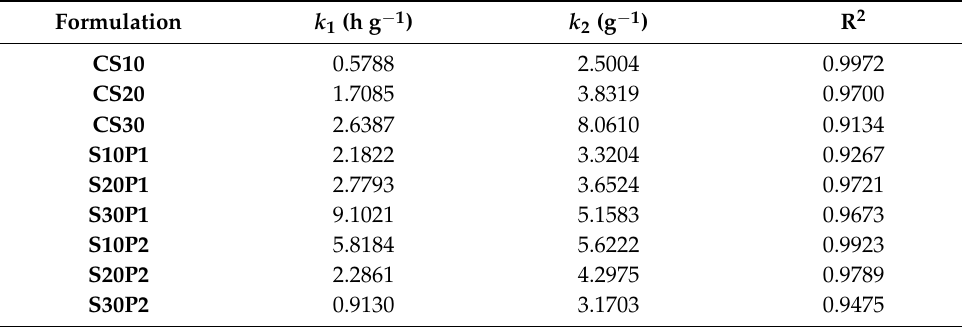
Figure 2. Comparisons of water absorption capacity (WAC) profiles of rice starch films at ( A ) 10, ( B ) 20 and ( C ) 30% w / w of sorbitol with different drug loadings (n = 3, mean ± SD). Table 2. Peleg rate constant ( k 1 ) and capacity constant ( k 2 ) for water absorption